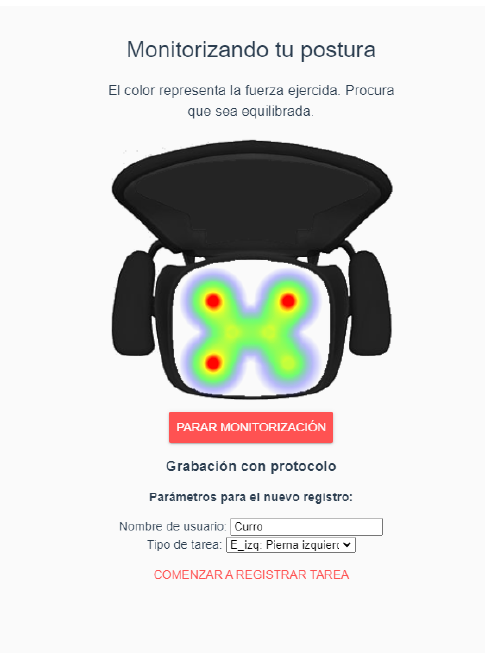
Figure 3. Screenshot of the PC application while a participant was using the seat. Captions in Spanish are displayed to the user for